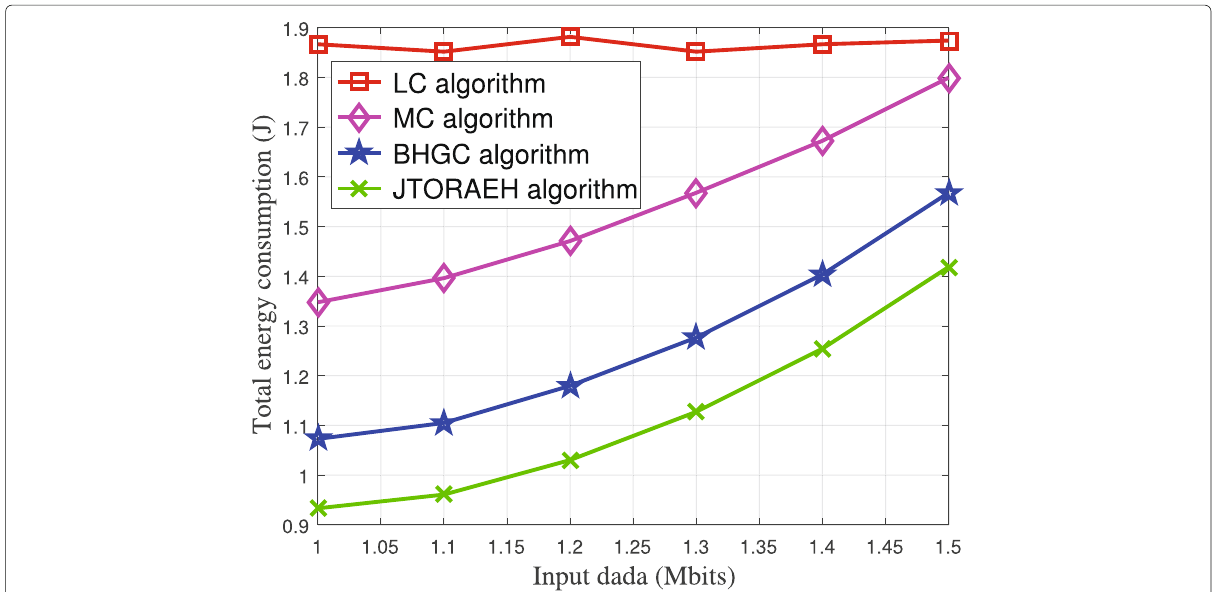
Fig. 7 Total energy consumption versus input computation file size of